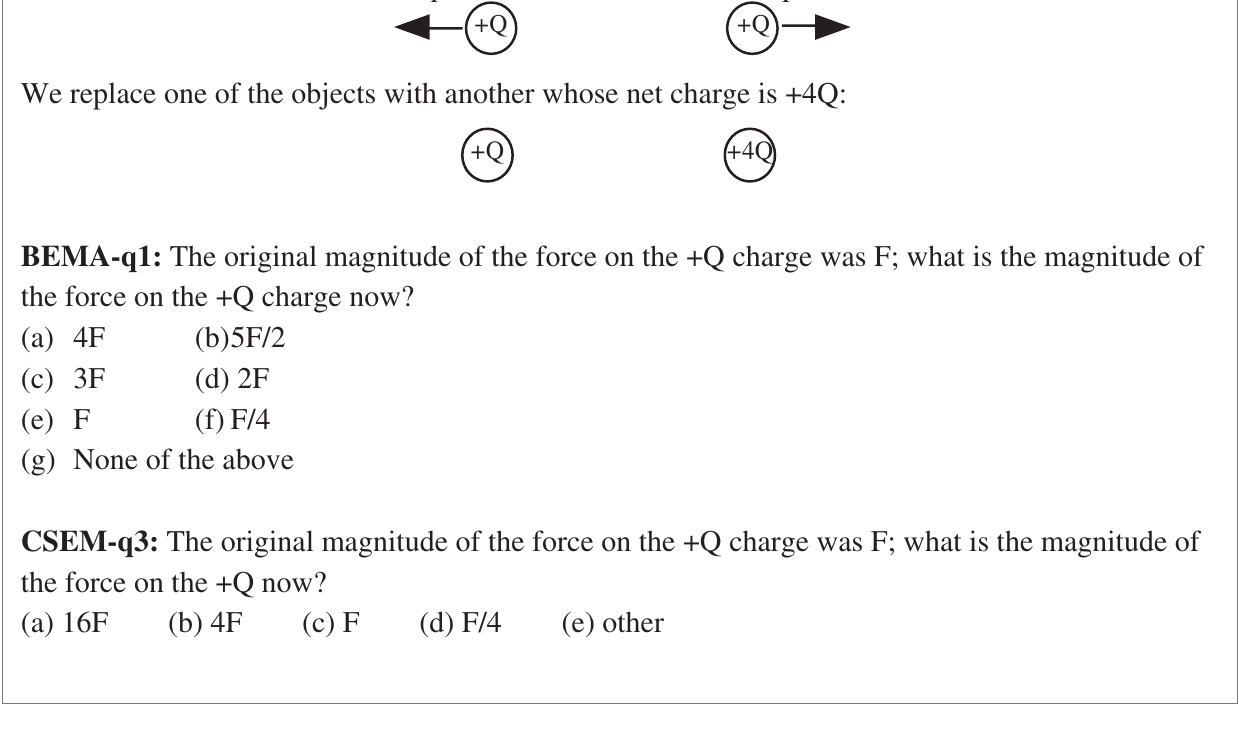
FIG. 10. BEMA-q1 and CSEM-q3. The number of choices of q1 in BEMA is more than that of q3 in CSEM, although the question scenarios are identical. The choice “ 16F ” in CSEM-q3 is not included in BEMA-q1. Three additional choices are added to the BEMA